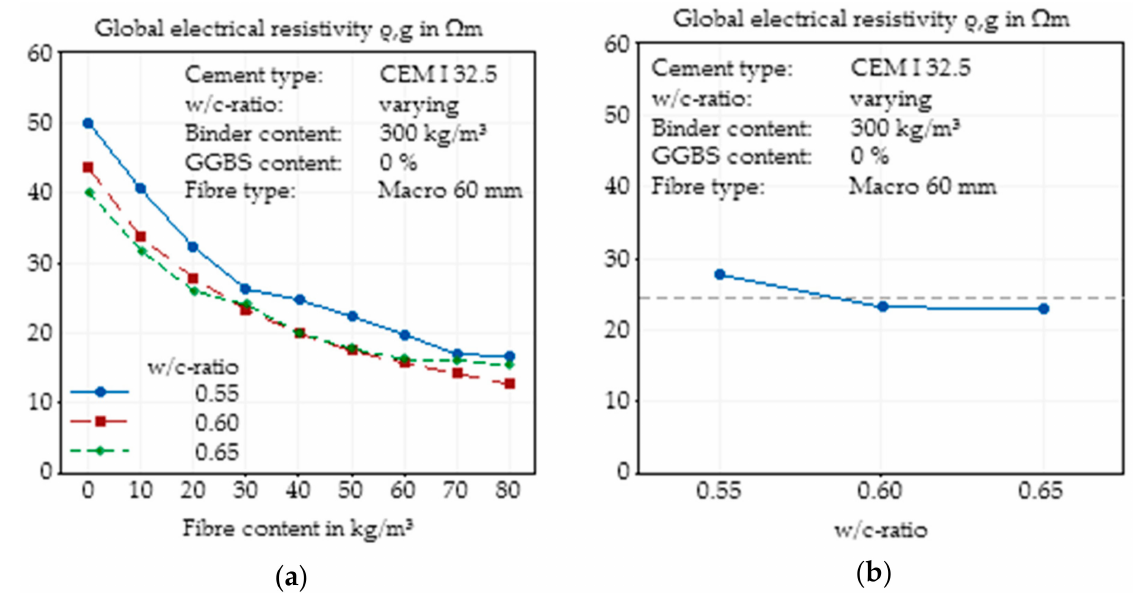
Figure 5. Effect of the water/cement ratio on the global electrical resistivity of SFRC as a function of fibre content ( a ) and main effect plot of the water/cement ratio on the global electrical resistivity of SFRC calculated by Minitab ( b